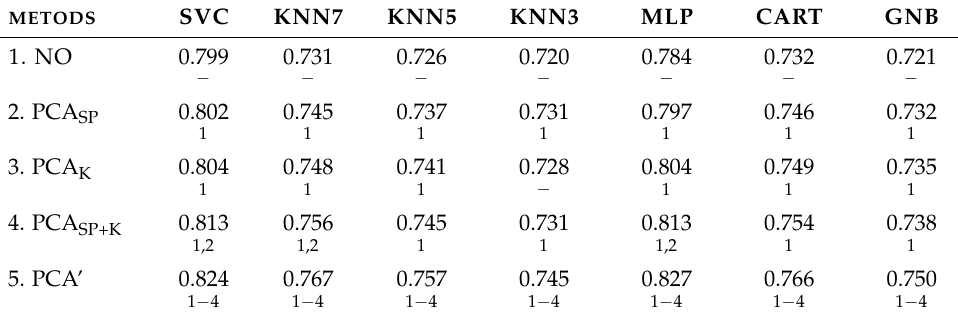
Table 1. Results of the experiment 1 when the proposed method was used to estimate the number of components and features with the BAC- score metric. The lines contain extraction methods and the columns contain